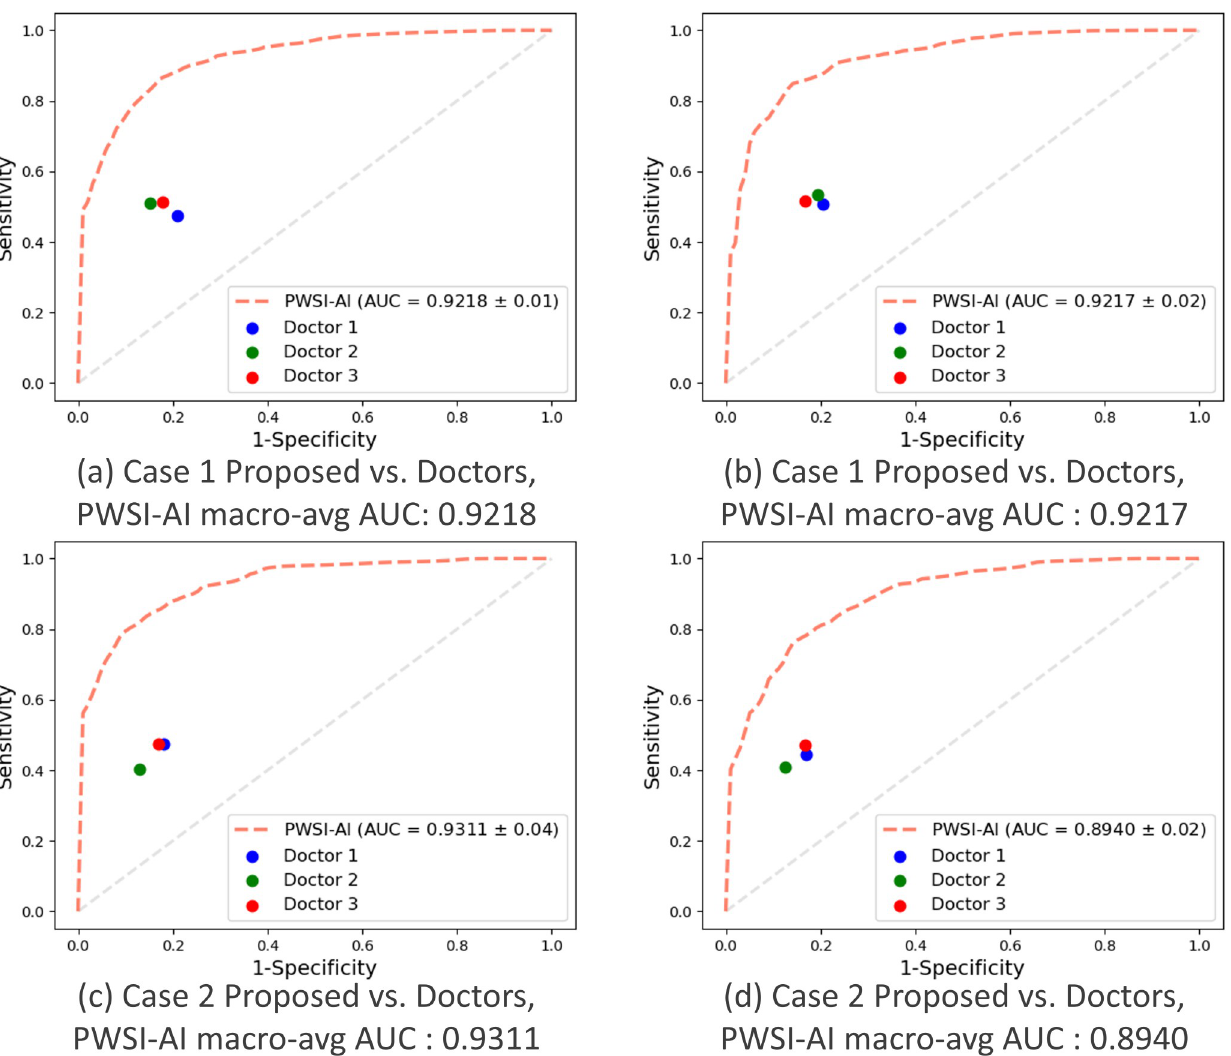
Fig 8. Comparison of the performance between the proposed PWSI-AI and doctors in terms of the AUC. (a) and (c) Autumn protocol, (b) and (d) Number protocol.